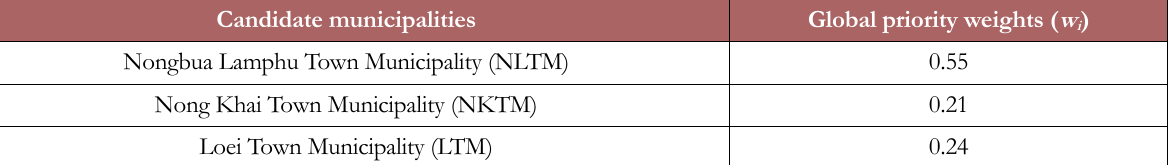
Table 4. Global priority weights of candidate